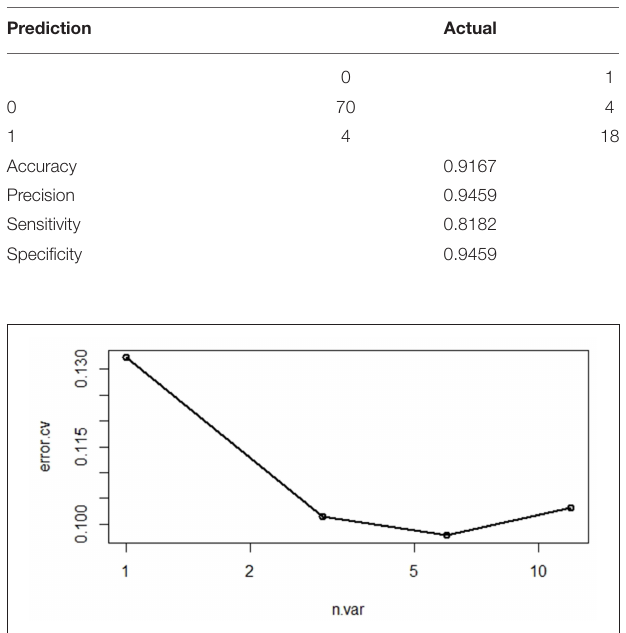
FIGURE 1 | Boruta screening feature results.